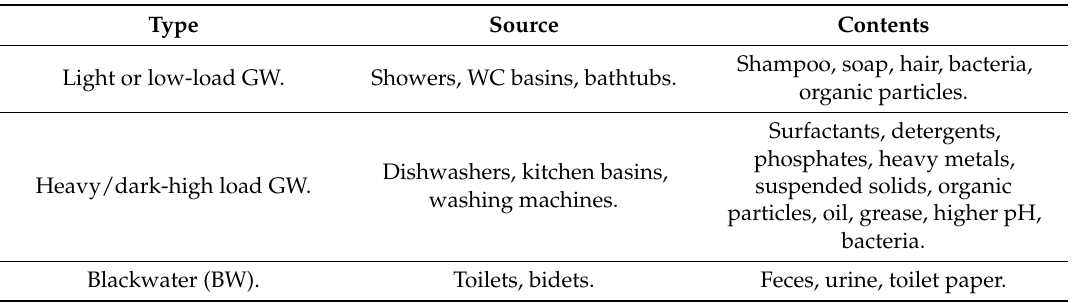
Table 1. Characterization of domestic sewage water.